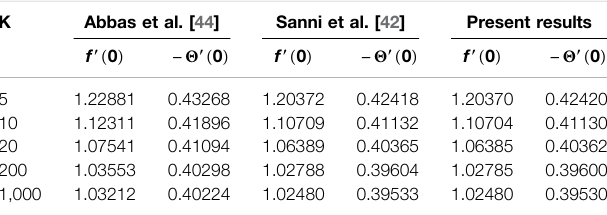
TABLE 2 | Comparison of the f ′ ( 0 ) and − Θ ′ ( 0 ) values for limiting case with the published results.